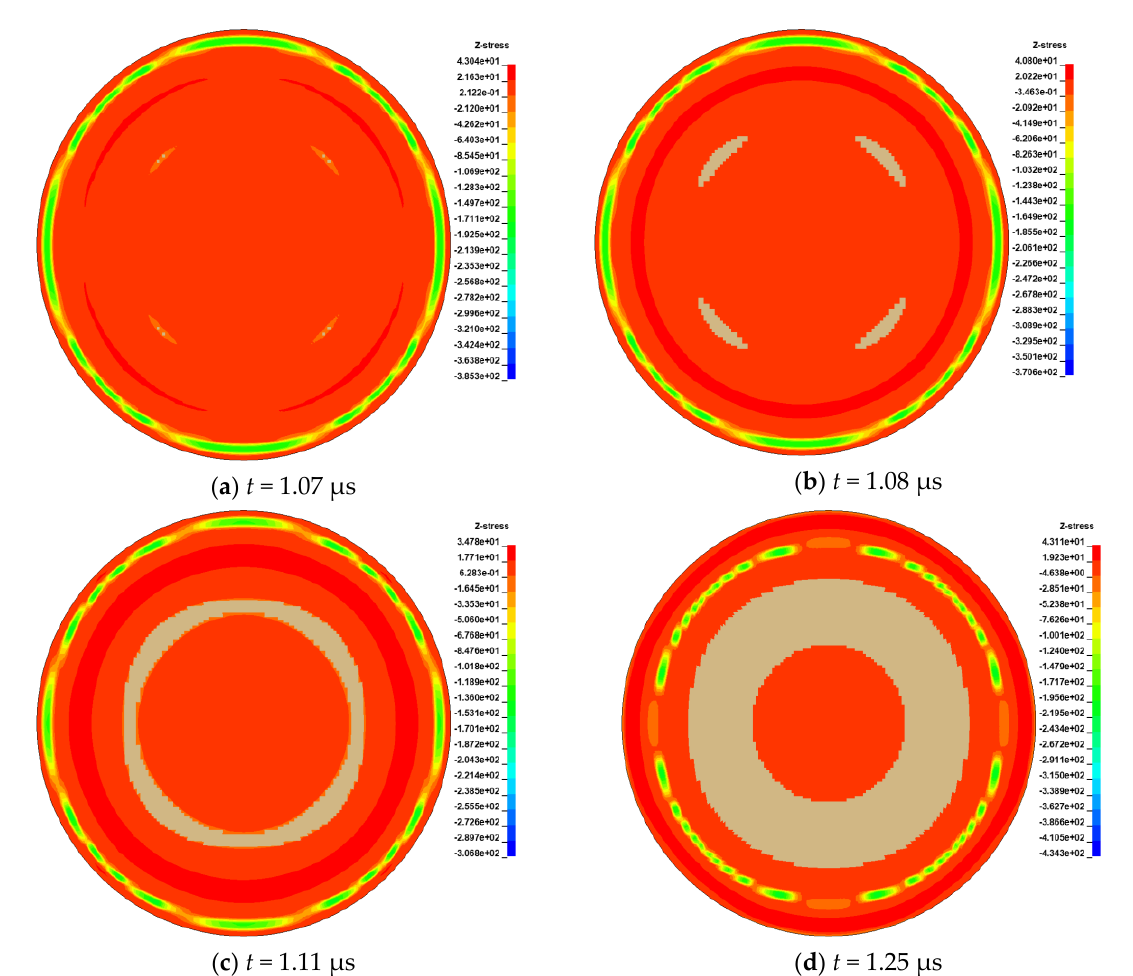
Figure 10. Predicted evolution of σ z stresses at the interface (cohesive area).